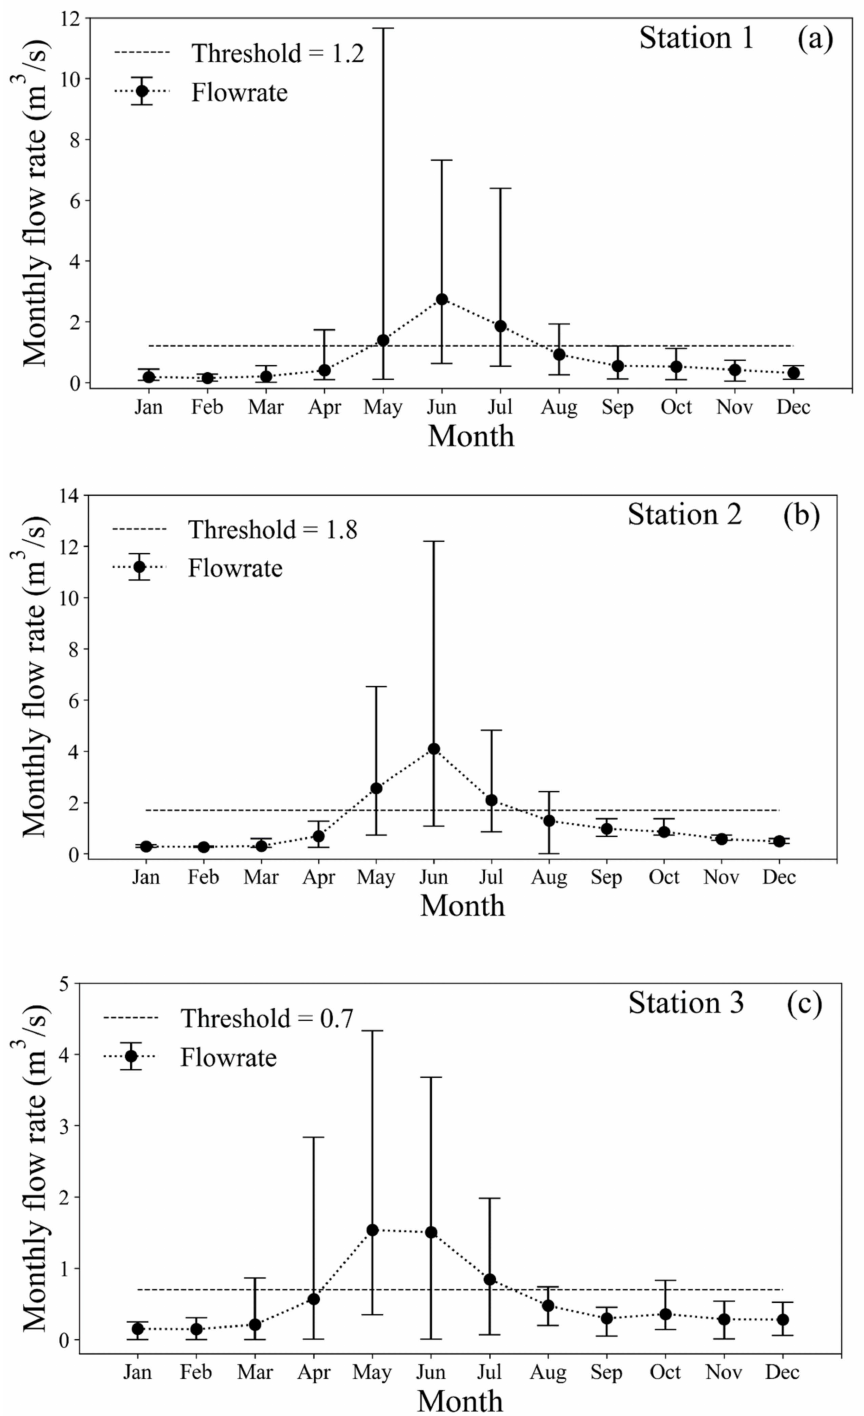
Figure 3. Average, maximum, and minimum monthly drainage flow rates and the spring freshet threshold for the three monitoring stations. ( a ) Station 1 with spring freshet threshold of 1.2 m 3 /s; ( b ) Station 2 with spring freshet threshold of 1.8 m 3 /s; ( c ) Station 3 with spring freshet threshold of 0.7 m 3